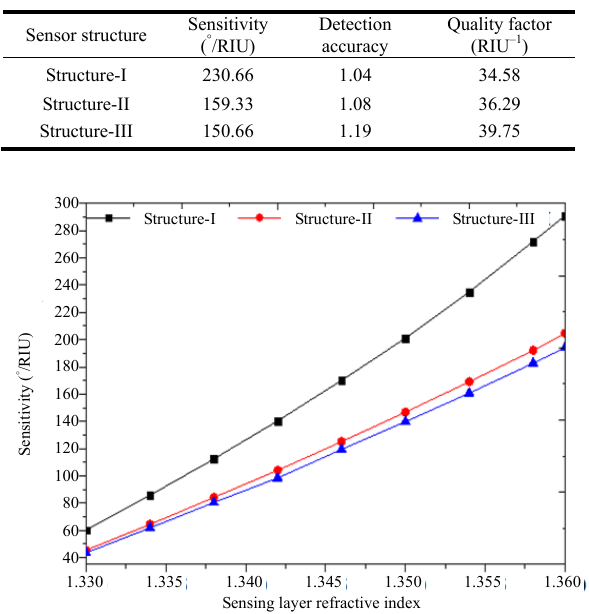
Table 3 Comparison table for sensitivity, detection accuracy, and quality factor.